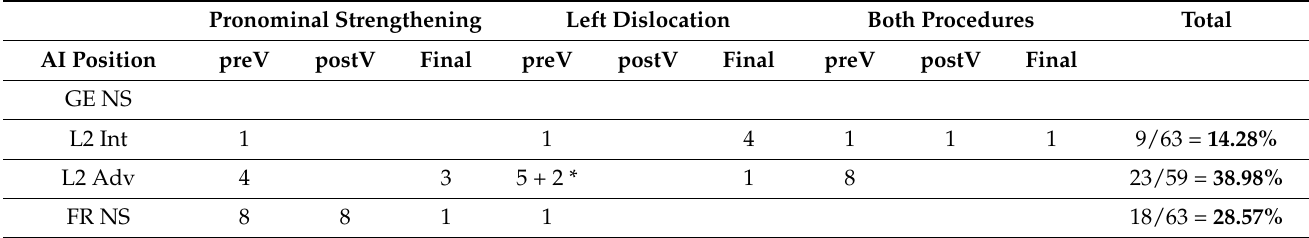
Table 7. Marked expressions of contrastive topics in L1 and L2.